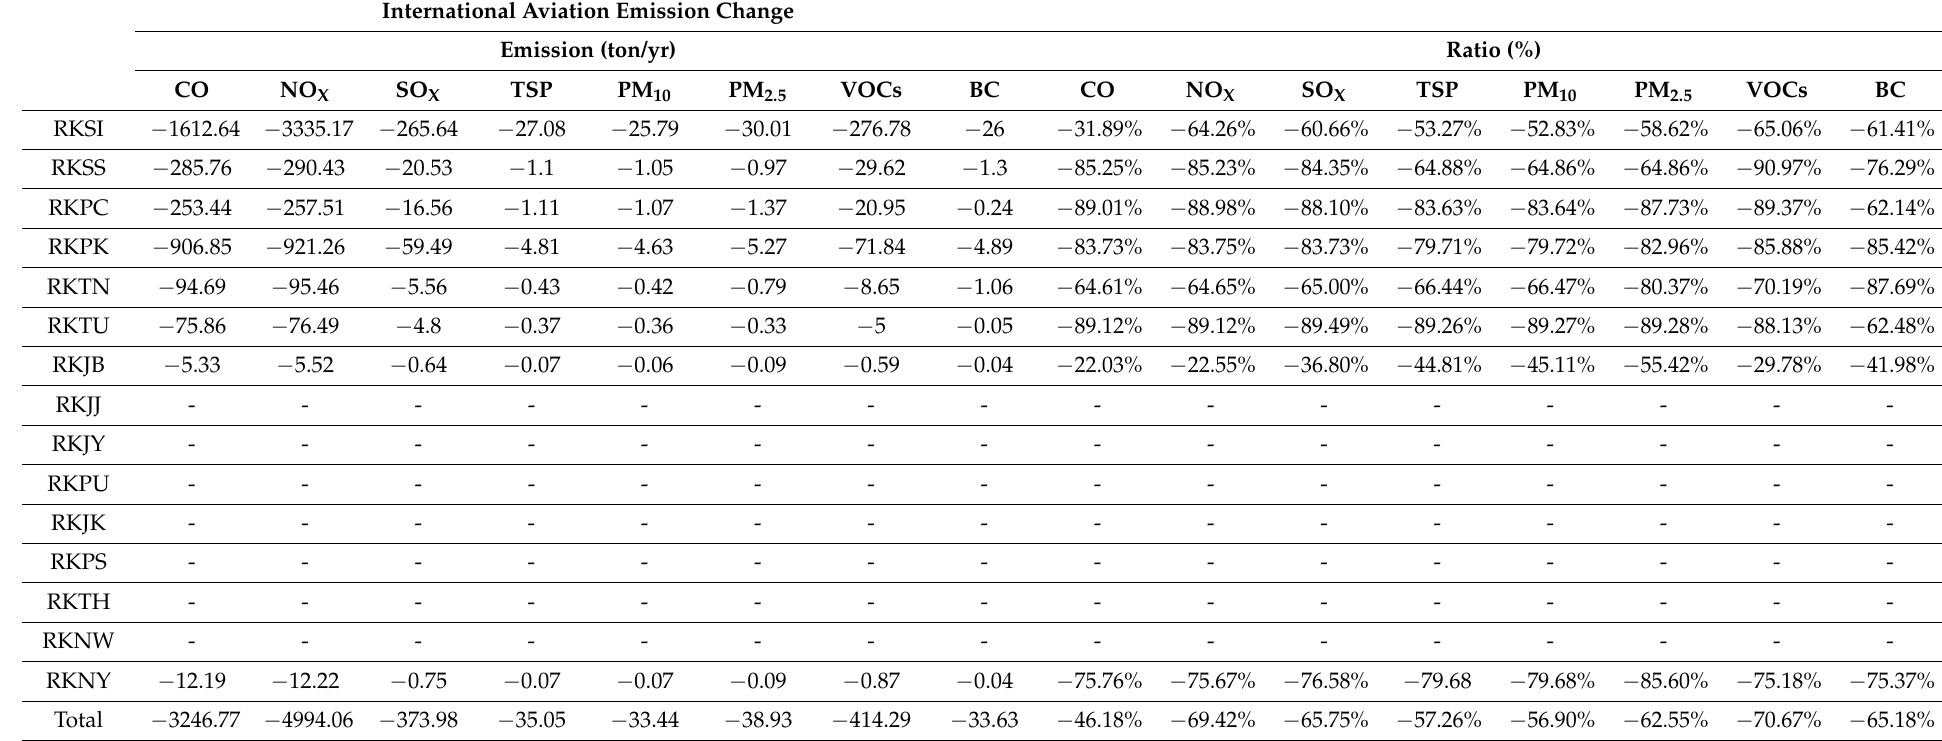
Table 4. Emissions Change due to COVID-19 in International Aviation